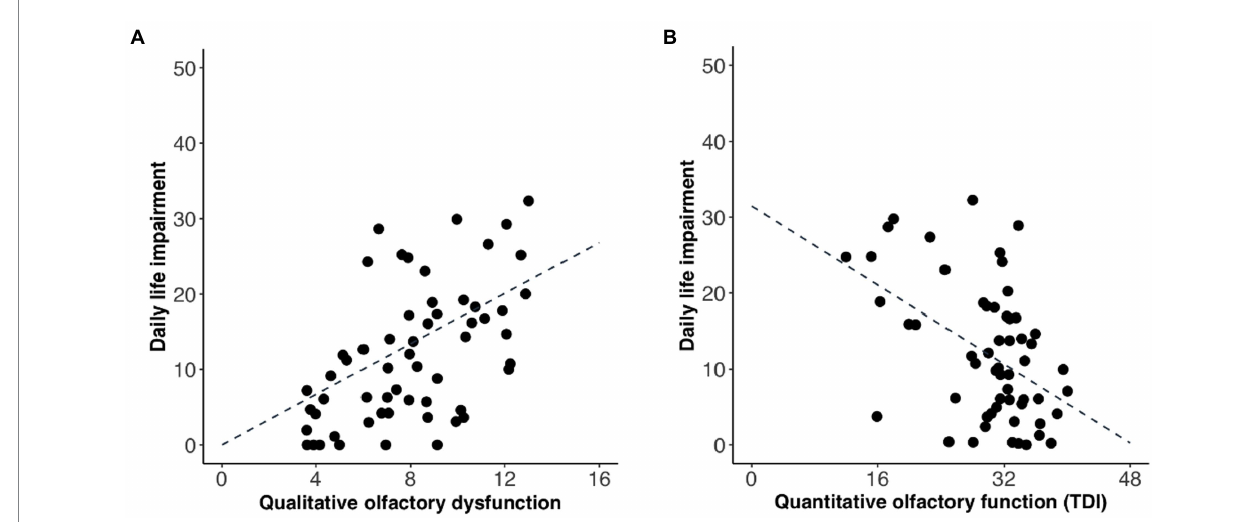
FIGURE 2 Relationship between average daily life impairment (QOD-NS score) and (A) degree of qualitative olfactory dysfunction and (B) quantitative olfactory function. Each data point represents one participant. Regression line is indicated by the intersected line. Scores are slightly jittered for visibility.